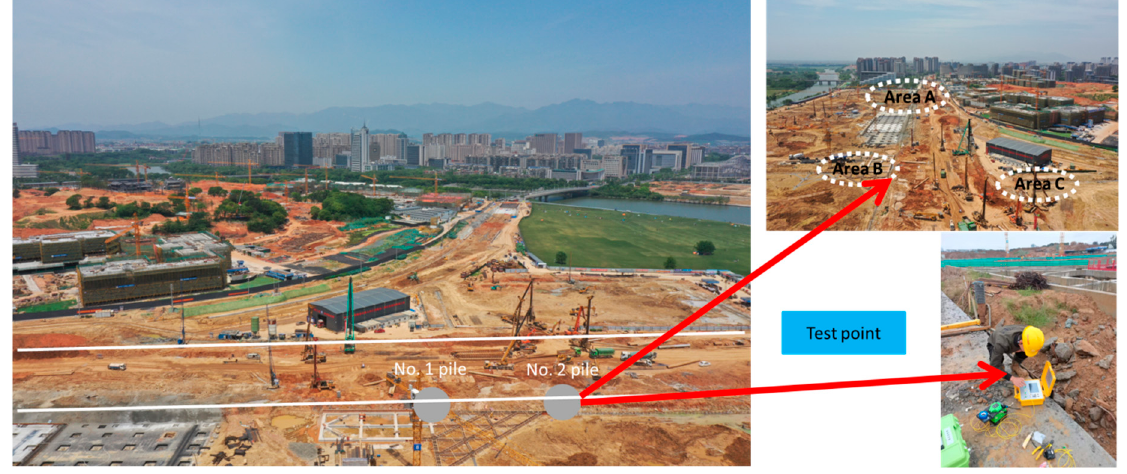
Figure 1. Project